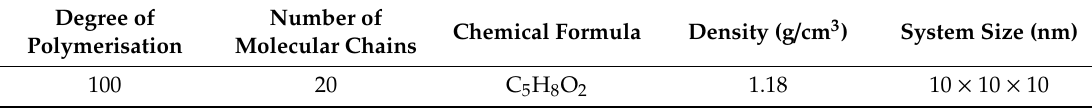
Table 1. Configuration parameters of the PMMA system.